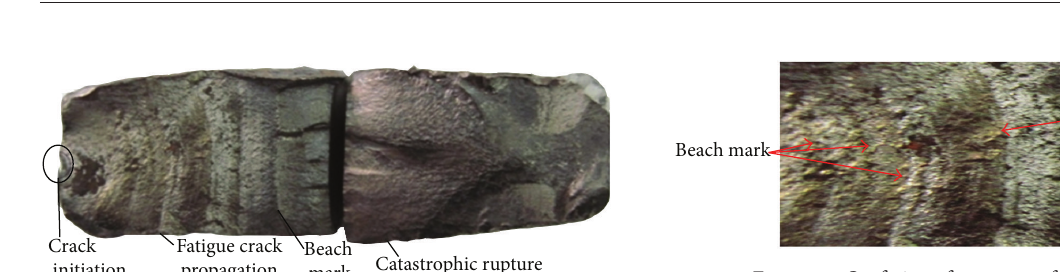
Figure 7: On fatigue fracture surface of